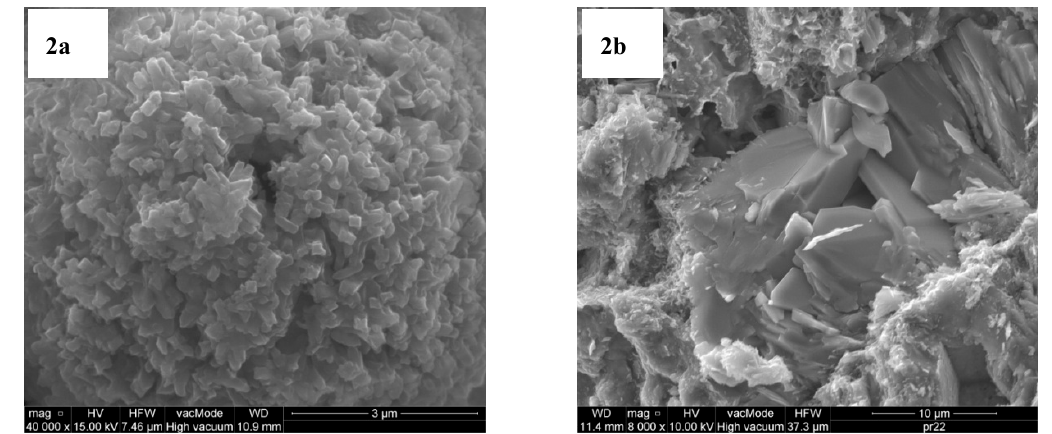
Figure 2. Scanning electron microscopy (SEM) images of Na-P1 ( a ) and clinoptilolite ( b ).